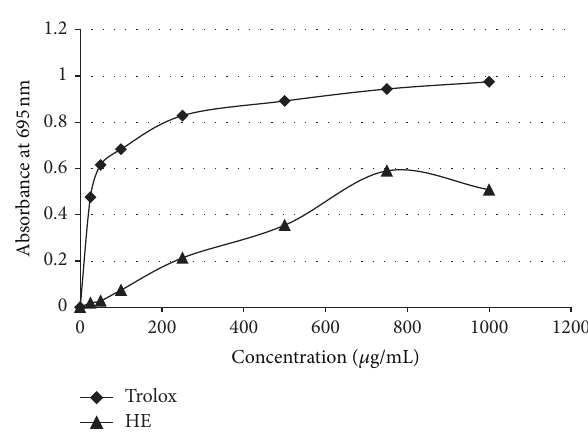
Figure 2: Total antioxidant capacity from cones essential oil of Cupressus sempervirens .